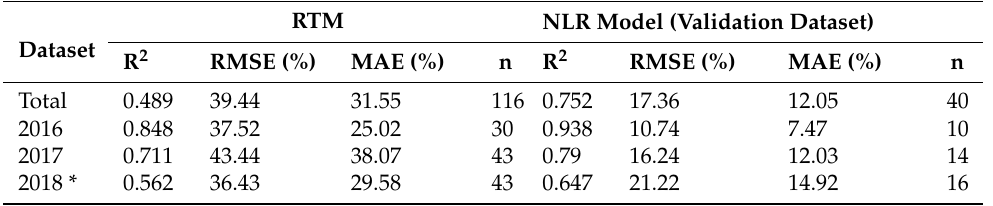
Table 6. Comparison between observed data and LFMC estimations from RTM simulations and NLR empirical model for MCD43A4 images. RMSE, root mean square error; MAE, mean absolute error; n, sample size.